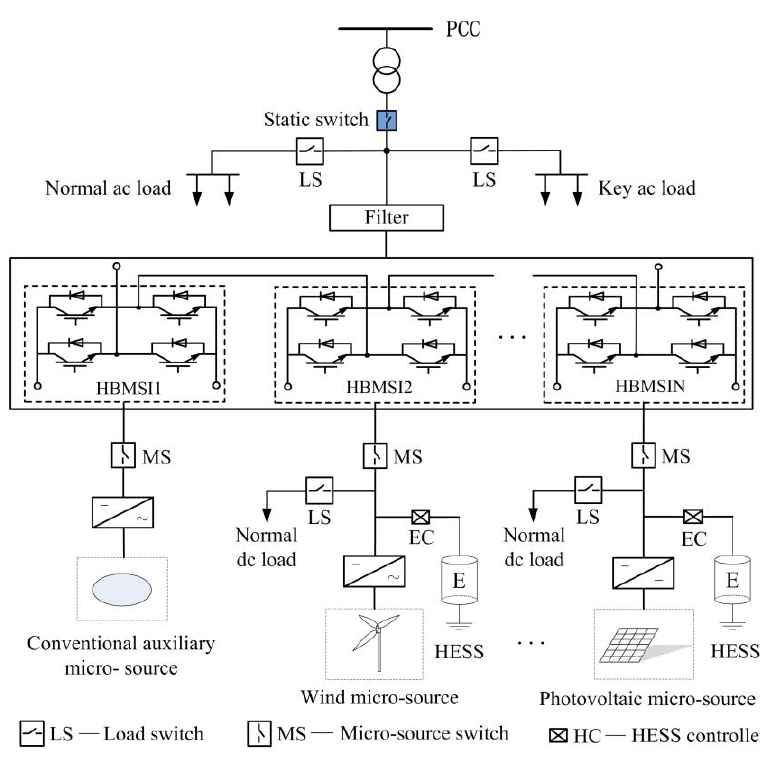
Figure 1. Configuration of one series micro-grid.